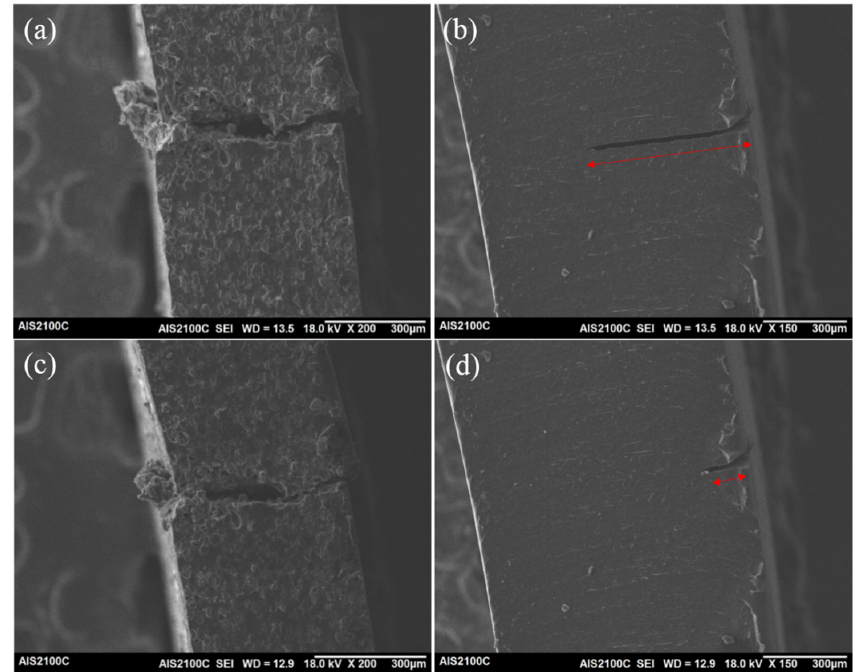
Figure 9. Microscope images of copolymers at 150 ° C before and after thermal treatment.